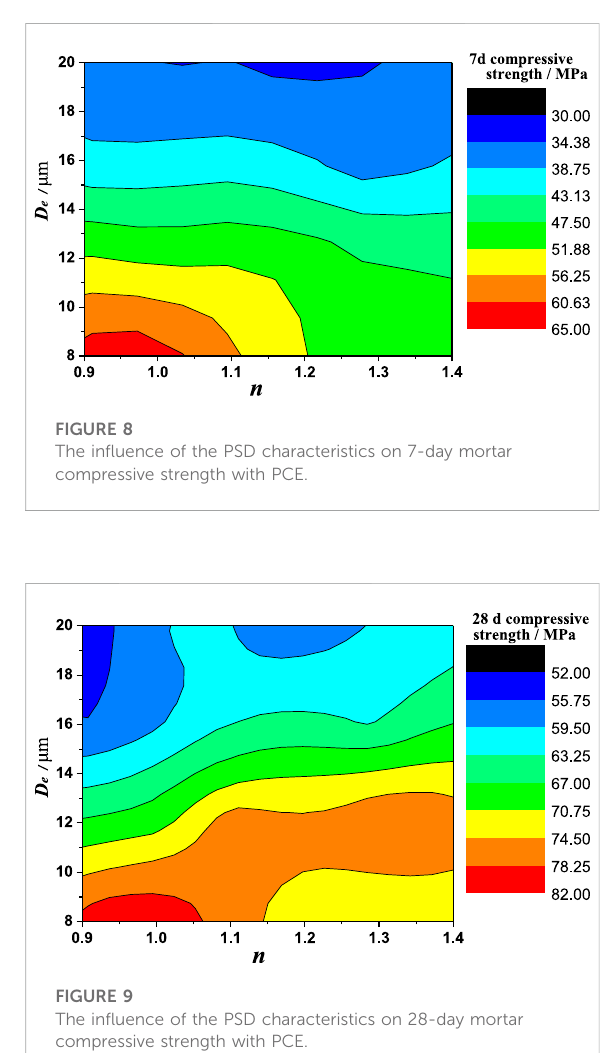
FIGURE 9 The in fl uence of the PSD characteristics on 28-day mortar compressive strength with